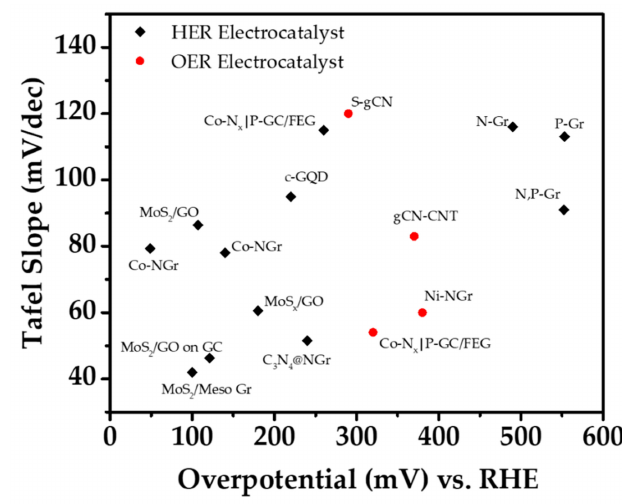
Figure 8. Plot for carbon-based materials in electrochemical systems. Table 1. Carbon-based materials for electrochemical water splitting reactions.